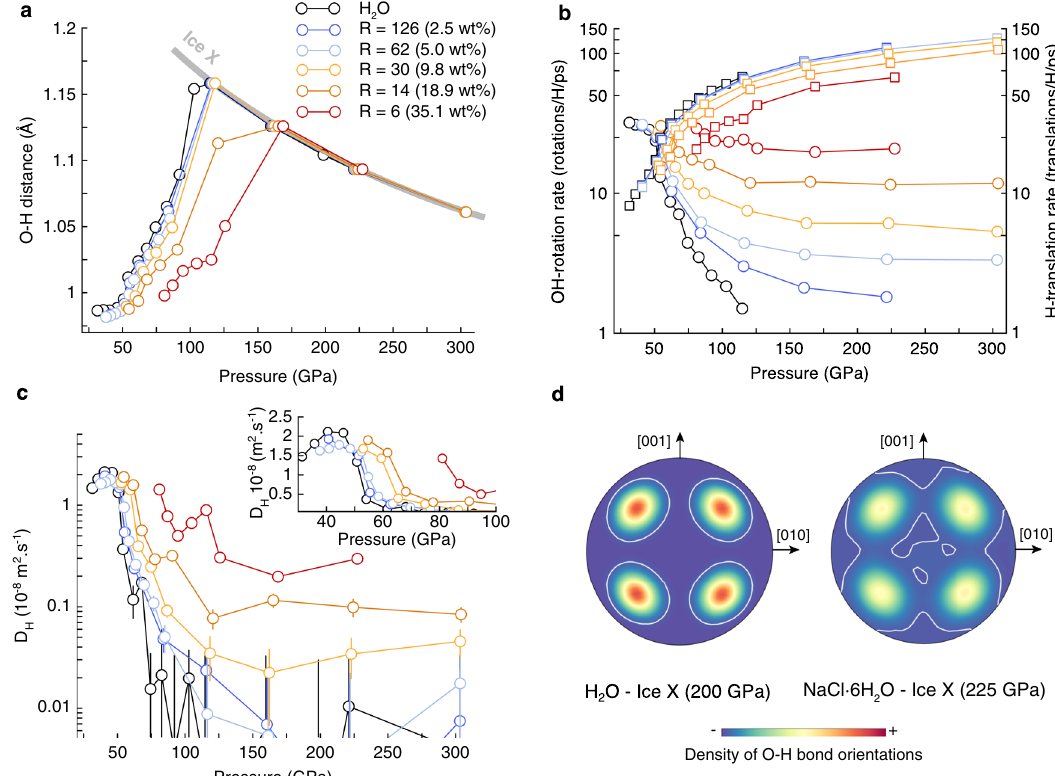
Fig. 2 H-bonding regimes in NaCl-bearing bcc ice at 1600 K. a Pressure dependence of the shortest O-H bond length. For a given NaCl concentration, OH reaches a maximum at the transition towards ice X. See text for more details. b OH-rotation rates (dots) and H-translation rates (squares) under compression in salty ice. c H diffusion coef fi cients ( D H ). The inset represents a zoom in the 30 – 100 GPa pressure range showing the increasing pressure of the onset of diffusion with increasing NaCl content. When non-visible error bars are smaller than the size of the markers. d Stereographic projection of the density distribution of O-H bond orientations in ice X. In pure and salty, the four maxima corresponds to the 111 h i directions as expected for O-H bonds aligned with the half-diagonals of the bcc sub-lattice. In salty ice the orientation distribution of the O-H bonds is broader than in pure ice, indicating that H atoms tends to delocalize more out of the 〈 111 〉 direction (OO axis) than in pure ice. The color scale is the same for the two distributions and the white lines contours the same density of O-H bond